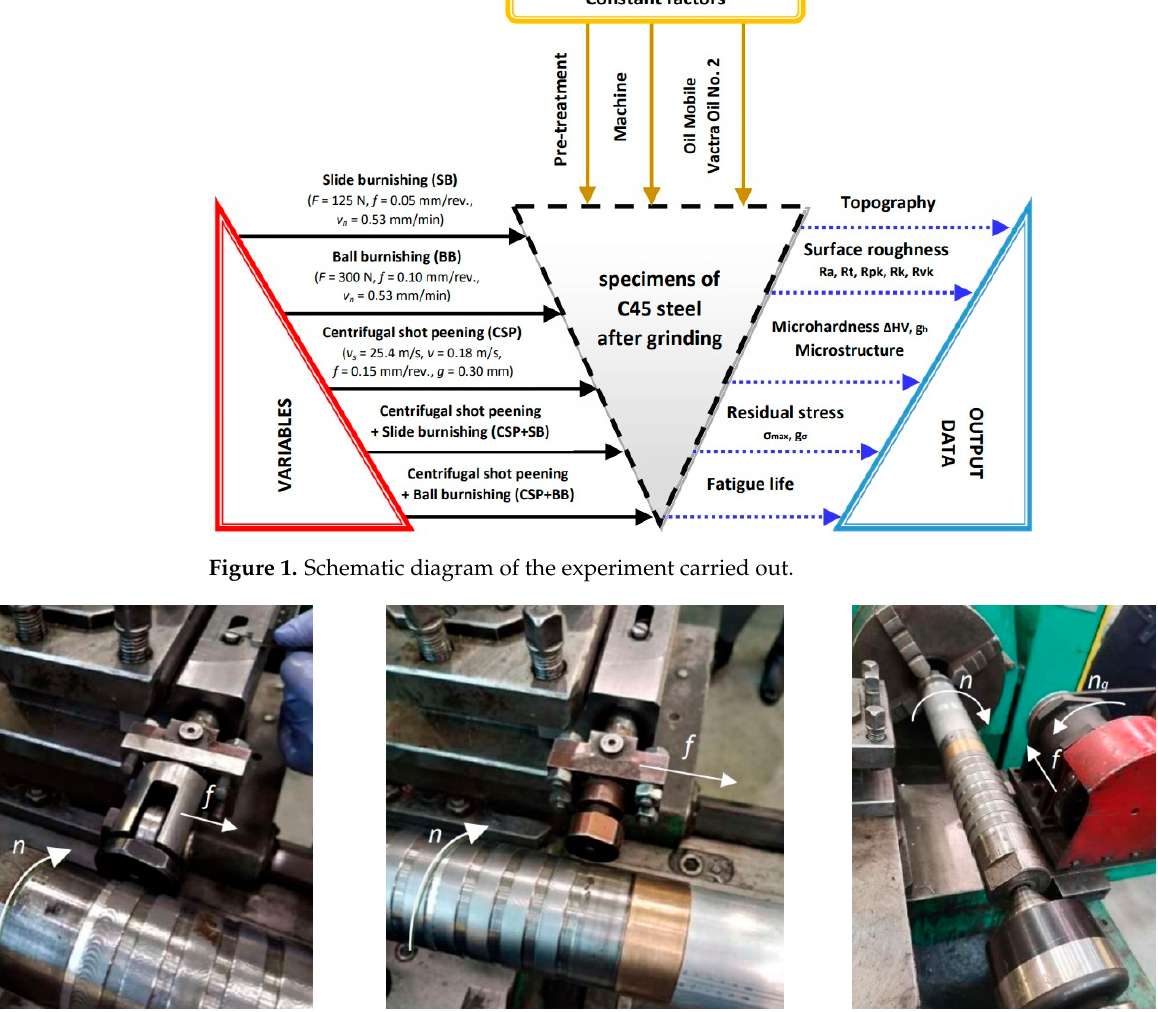
Figure 2. View of the stands and tools used in the experiment: ( a ) ball burnishing, ( b ) slide burnishing, ( c ) centrifugal shot peening ( f —feed, n —rotational speed of the sample, n g —rotational speed of the head).